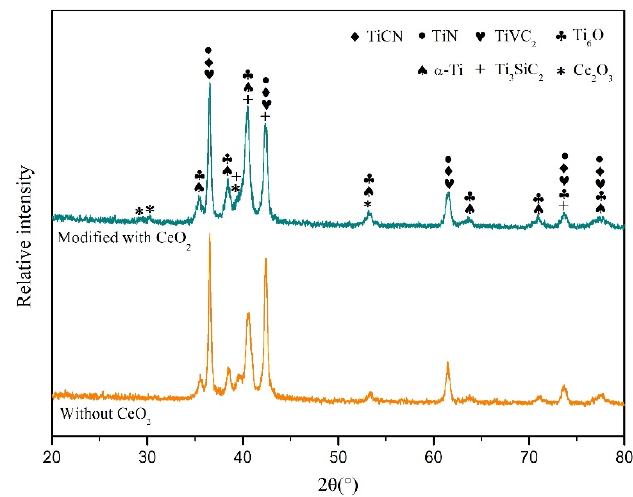
Figure 3. XRD spectrum patterns of the Ti-based ceramic coatings.